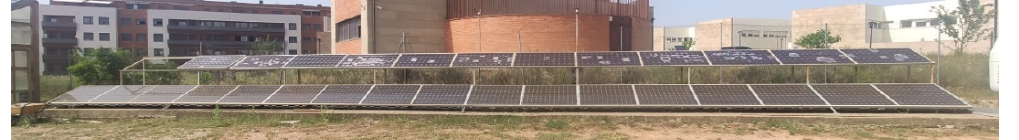
Figure 6. PV plant on Duques de Soria campus of the University of Valladolid. Table 1. Technical characteristics of the PV module.